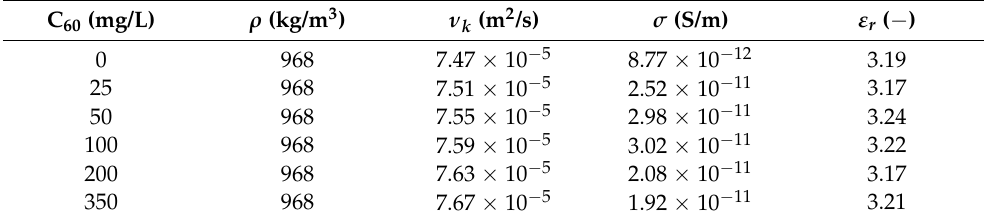
Table 4. Properties of C 60 fullerene doped Midel 7131 synthetic ester (20 ◦